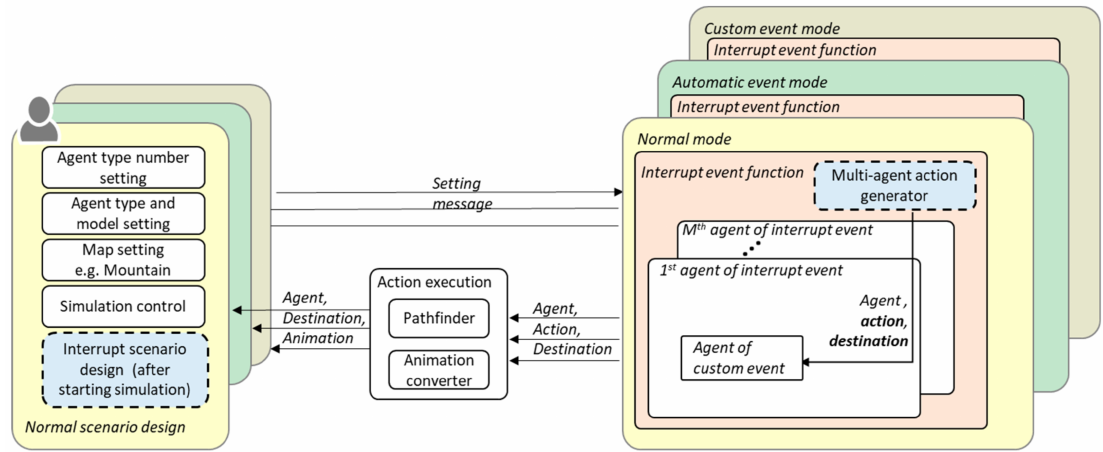
Figure 7. Overview of the interrupt event